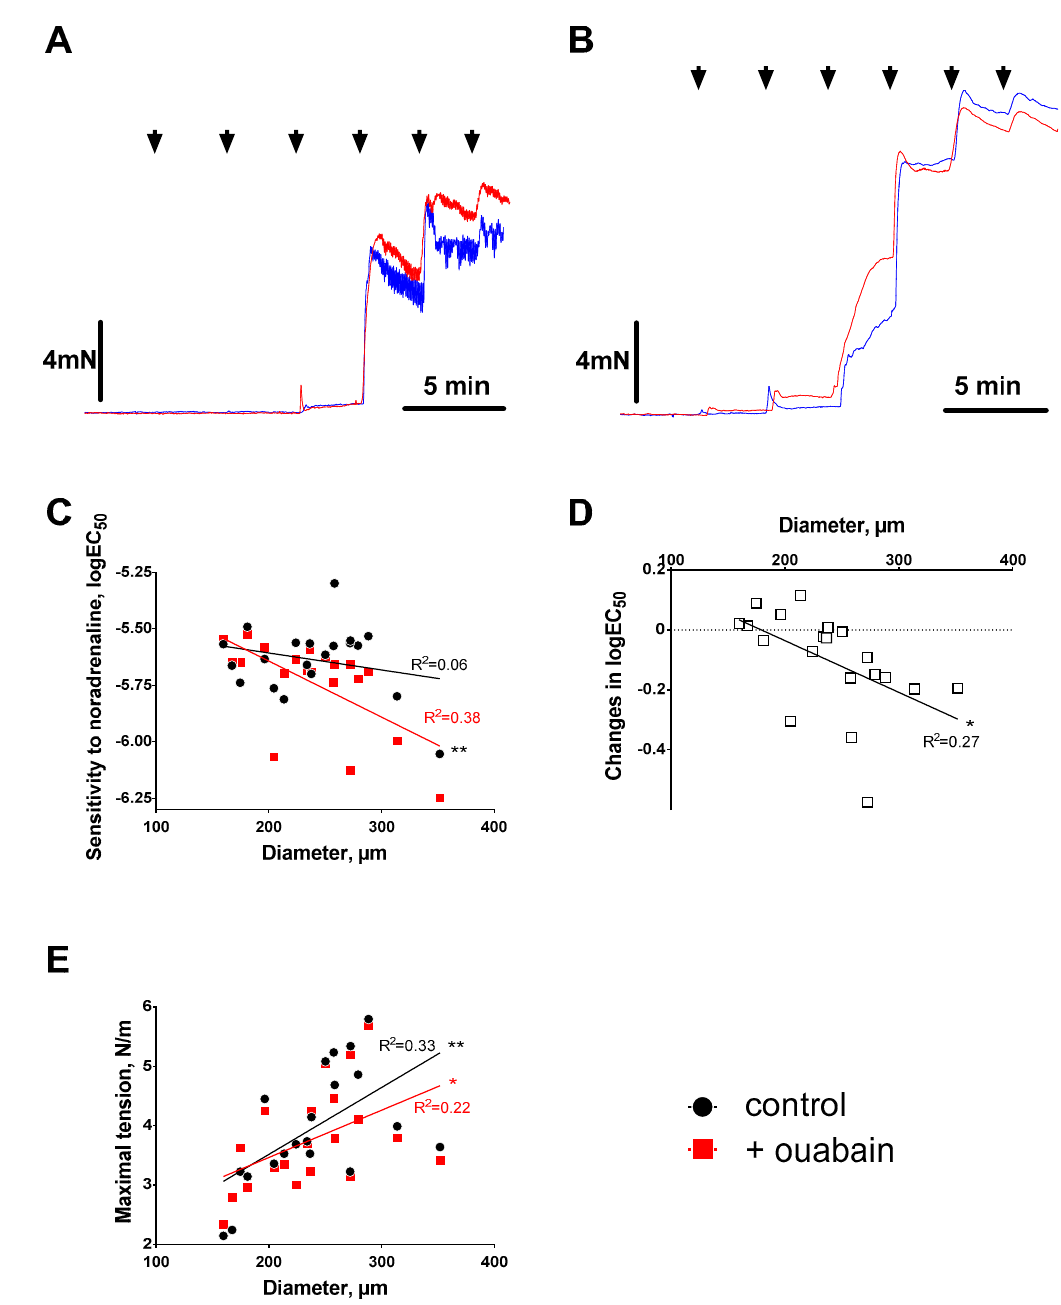
Figure 1. Effect of ouabain on agonist-induced contraction varies with arterial diameter. ( A , B ) show representative concentration–response curves for noradrenaline-induced contractions of mesenteric arteries before (blue) and after 15 min incubation with 10 µM ouabain (red). Inner diameter of the artery in A was 167 µm, and the artery in B–314 µm. Noradrenaline was applied in concentrations of 0.1, 0.3, 1, 3, 10, and 30 µM as indicated by arrows. Sensitivity of arteries to noradrenaline was expressed as logEC 50 (in ( C ) and was measured for each arterial segment under control conditions and in the presence of ouabain. Ouabain-induced changes in the sensitivities are shown in ( D ) as the difference between sensitivities in the presence of ouabain and under control conditions. ( E ) shows maximal tension responses to 30 µM noradrenaline under control conditions and in the presence of ouabain. Values for goodness-of-fit of linear regression (R 2 ) are indicated by the lines. p < 0.05 (*) and p < 0.01 (**), n = 20.